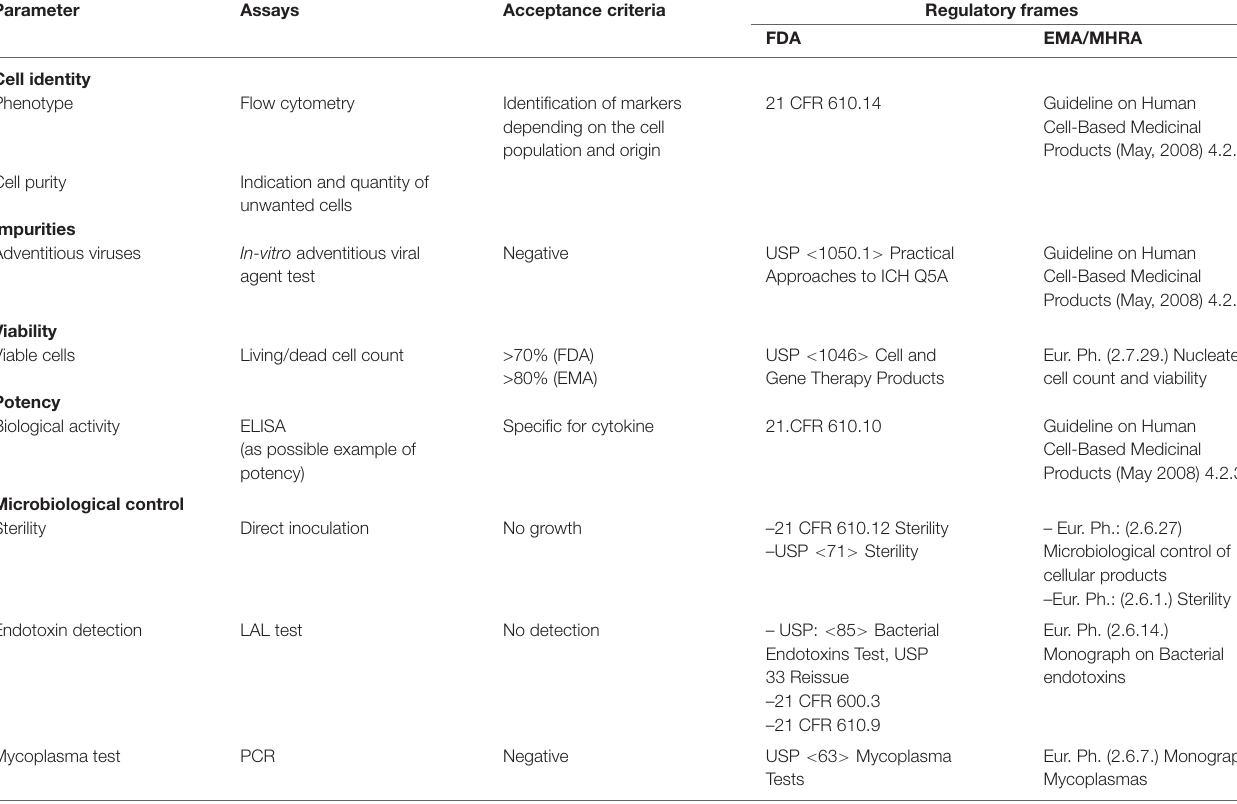
TABLE 7 | Release specifications for hMSC-based products according to GMP standards of the two major regulatory